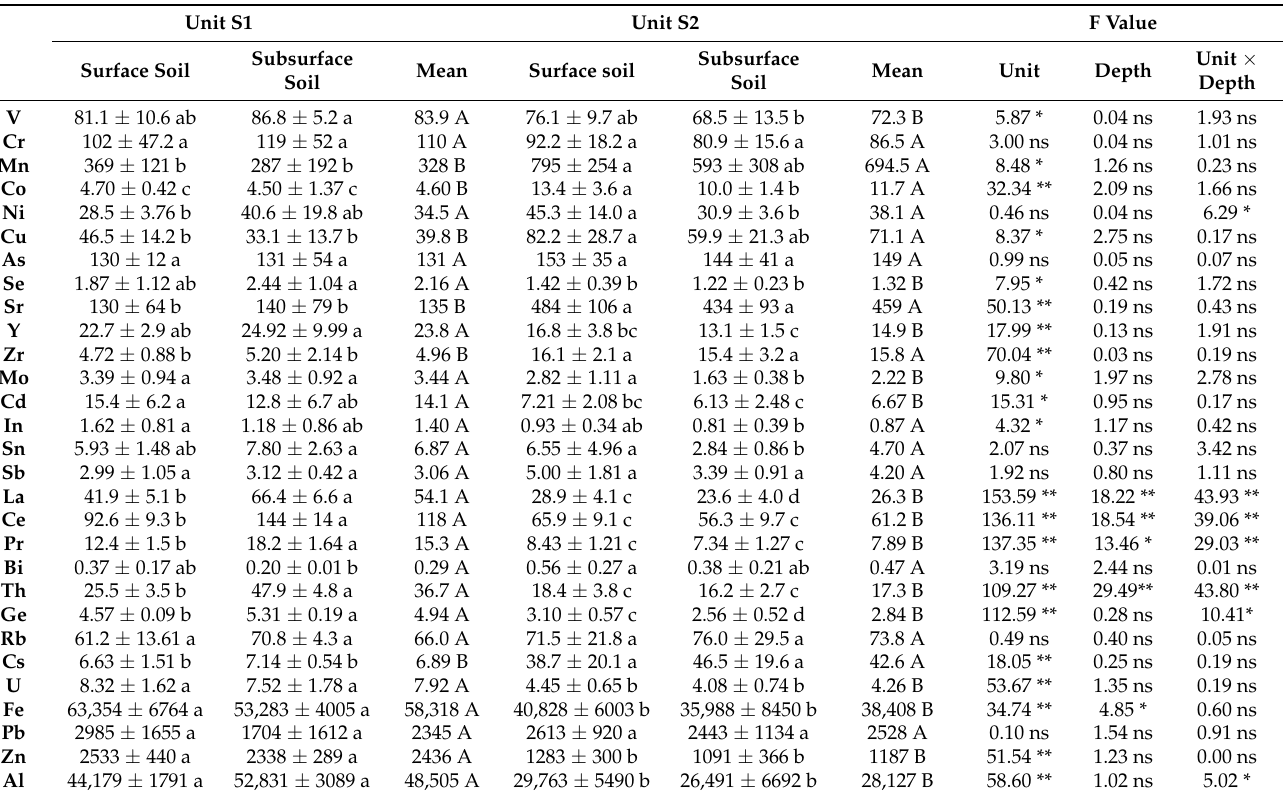
Table 2. Total concentrations of metals and REEs (mg kg − 1 ) in surface (0–15 cm) and subsurface (15–30 cm) soils from Units S1 and